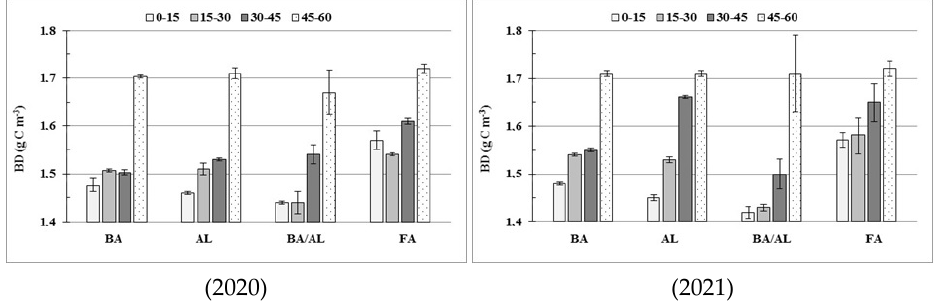
Figure 5. Evolution of the BD as a function of the depth in the soils of the four types of vegetation. Regarding the content of C and N, overall, an improvement was recorded in the culti- vation plots of BA, AL, and BA/AL. For the organic carbon content, the best increase was observed in the intercropping BA/AL sub-plot. In fact, in the surface layer (0–15 cm), the content was of the order of 1.87% in 2020 and increased further in 2021 to reach a value of 3.96% in 2021. This improvement was really throughout the profile down to the depth of 45–60 cm. What was observed with the organic carbon contents was the same as with the total nitrogen content. The best increases in N content were with soils of the intercropping of barley and alfalfa (BA/AL) with levels of 0.14% in 2020 and 0.33% in 2021, respectively. Al- falfa cultivation alone showed an increase but did not exceed 0.14%, half of what exists in the soil of the BA/AL intercropping for the same 0–15 cm layer (Table 3). However, the low- est nitrogen content was with barley alone, where the content did not exceed 0.07%, a value very close to fallow for the same 0–15 and 15–30 cm layer. Overall, the C/N values in 2020 were between 10.43 and 16.13 at the surface and be- tween 4.5 and 5.4 at depth, respectively. In 2021, the values were between 10.93 and 19.93 at the surface and between 4.4 and 5.07 at depth, respectively. These results clearly show that the mineralization of organic matter is much faster on the surface in comparison with the deep layer, where the organic matter appears to be poorly mineralized (Table 3). 3.3. Carbon Stocks During the two years, SOC and soil N stocks were calculated in all four sub-plots; the fallow (FA), the sole crop BA, the sole crop AL, and the intercropping BA/AL. For the C stock in June 2020, the analysis showed that the two unique crops of barley and alfalfa had very close stocks, with 8.57 and 9.15 kg C m − 2 , respectively. The intercrop- ping barley-alfalfa sub-plot showed a higher stock in the first three layers 0–15, 15–30, and 30–45 cm compared to their analogs of all other sole crops and fallow. In the second year of 2021, the storage of C in the nodule zone (0–15 and 15–30 cm) was significantly higher in intercropping culture than in sole culture. Figure 6 clearly shows this difference in the se- questration of C.